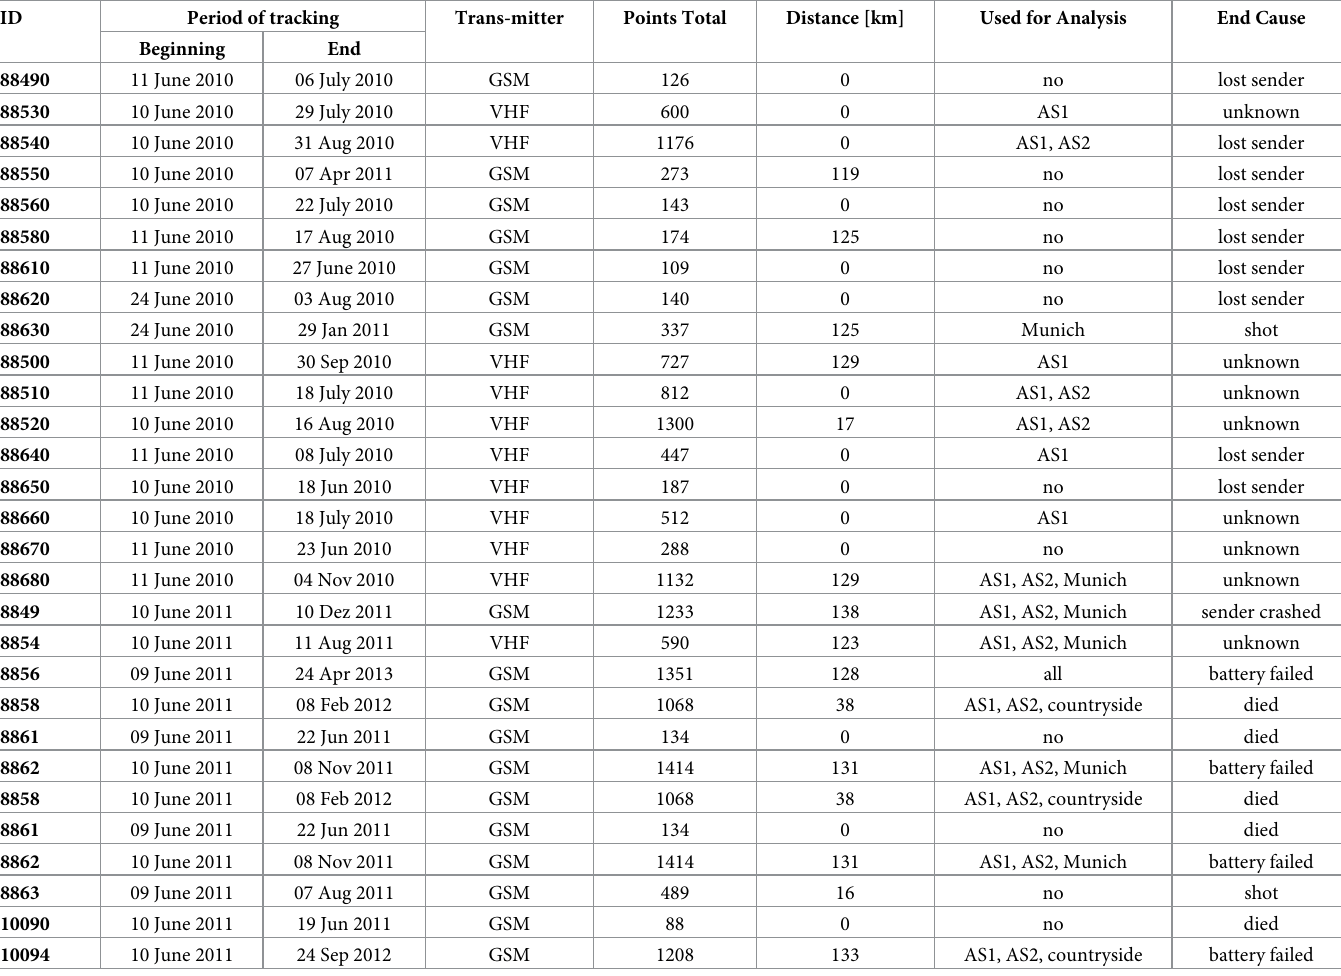
Table 1. Data for 30 greylag geese fitted with transmitters at the Altmuehlsee lake in Germany between 2010 and